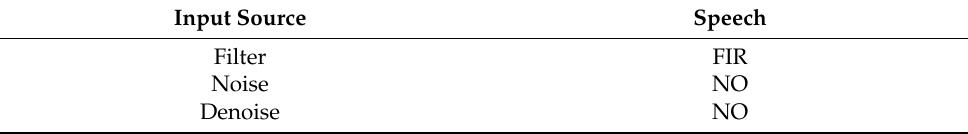
Table 2. Simulation parameters of scenario 1.